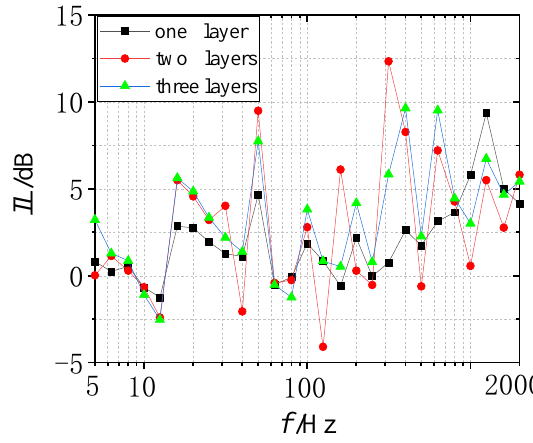
Figure 14. Insertion loss octave curves of pipeline with different coated layers.